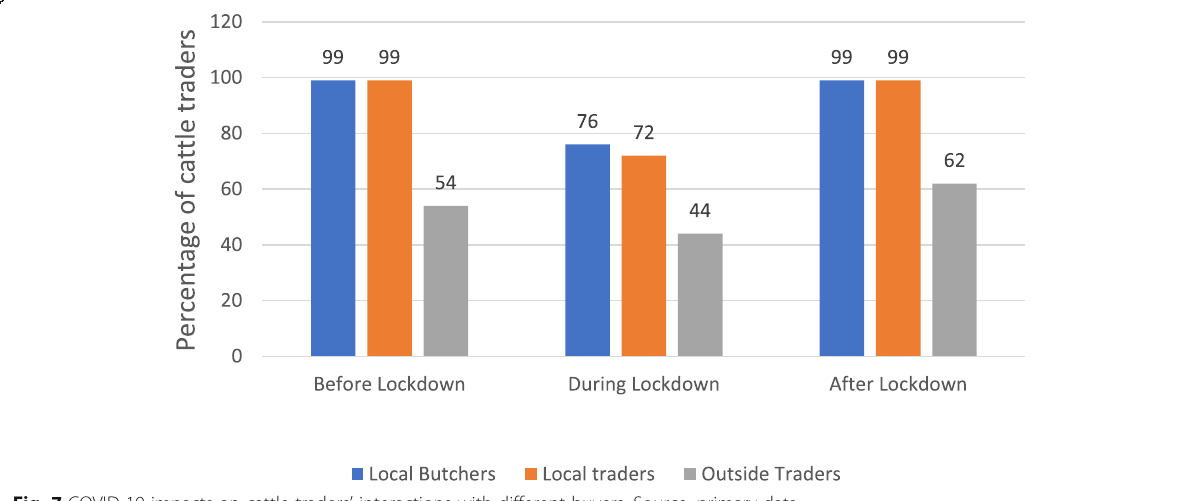
Fig. 7 COVID 19 impacts on cattle traders ’ interactions with different buyers. Source: primary